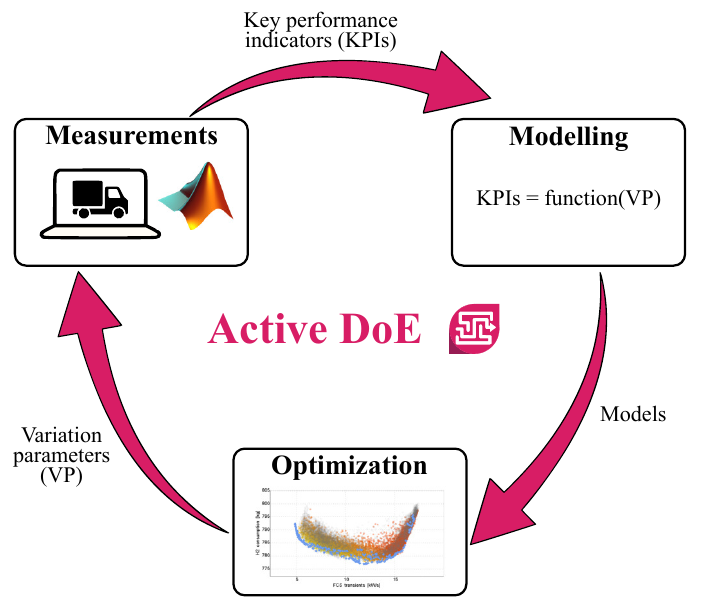
Figure 7. Representation of the Active DoE approach adopted by AVL